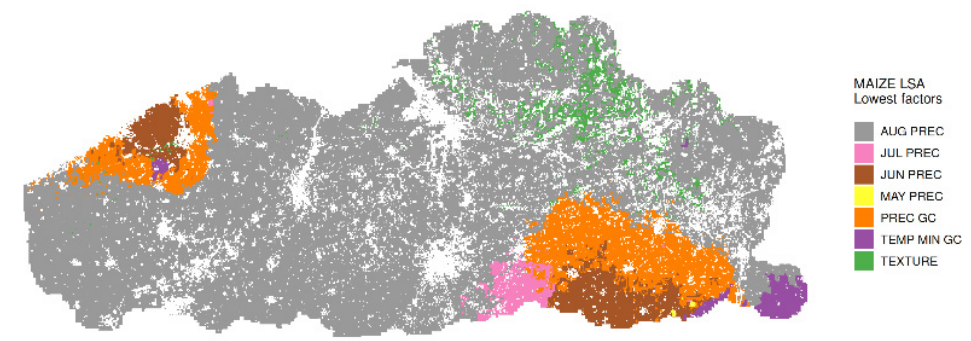
Figure 5. Input parameters with the lowest score for maize in Flanders.